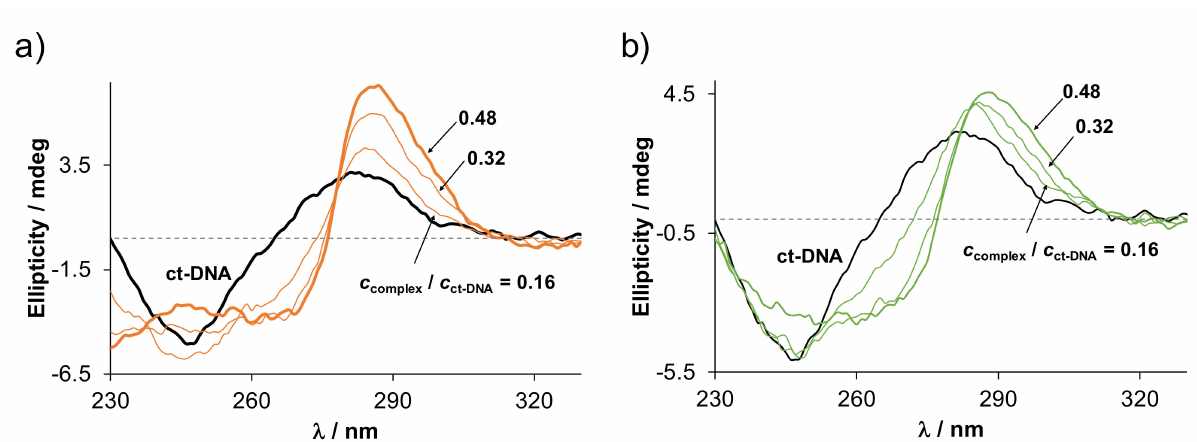
Figure 12. CD spectra of ct-DNA in the absence and presence of various equiv. ( a ) RhCp*-D-HQCl-hPro and ( b ) RuCym- D-HQCl-hPro. (The unit mdeg is millidegree.) {c complex = 0–47 µ M, c ct-DNA = 98 µ M, c KCl = 4 mM; pH = 7.40 (20 mM phosphate buffer); (cid:96) = 1 cm} Notably, at higher than 50 µ M complex concentration no reliable spectra could be recorded due to the high absorbance of the